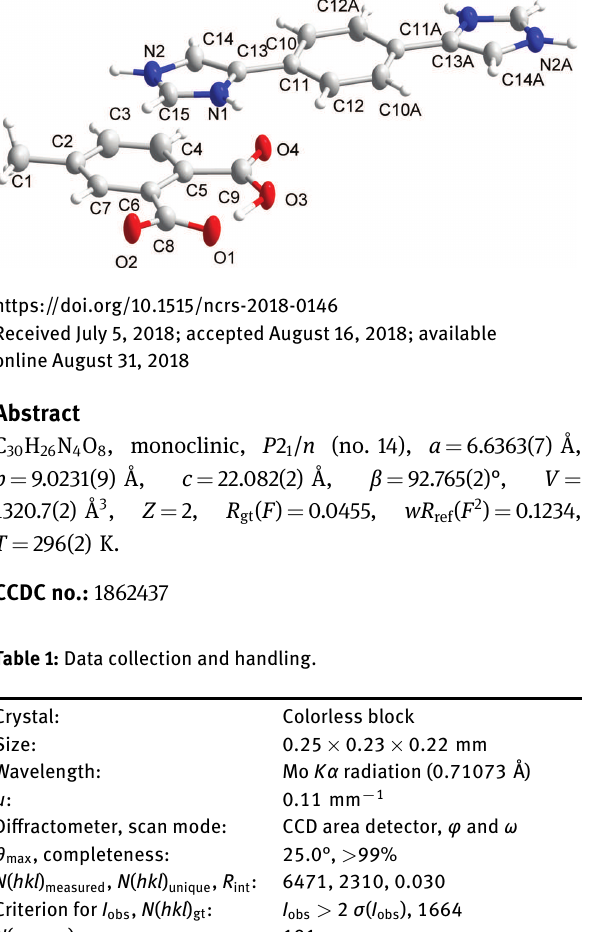
Table 2: Fractional atomic coordinates and isotropic or